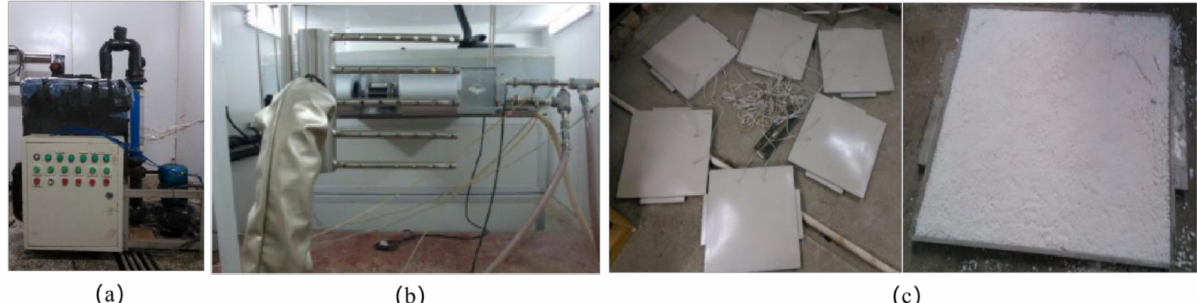
Figure 4. Main installations of the test-bed: ( a ) PCM storage tank; ( b ) Fan coil unit; ( c ) Phase change heat storage plates.